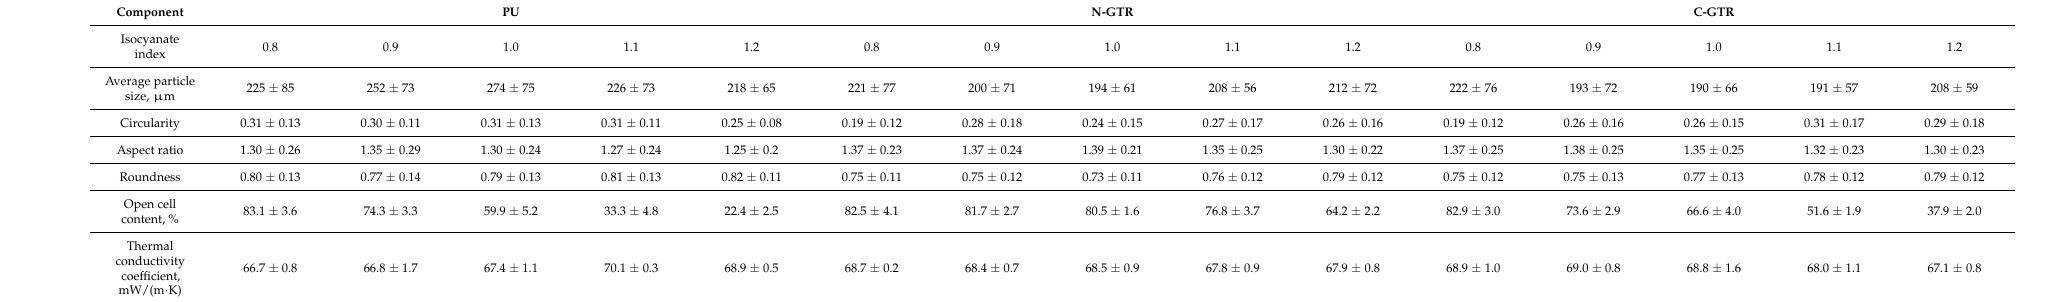
Table 2. Parameters of cellular structure and thermal conductivity coefficients for prepared PU foams and PU/GTR